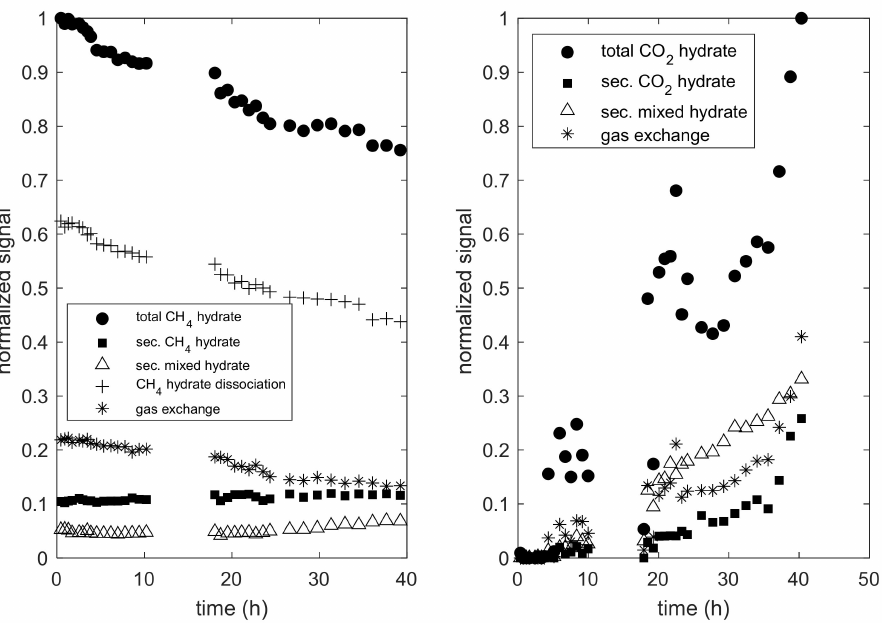
Figure 10. Evolution of the total gas-hydrate signal of experiment NoFlowI2 and evolution of the specific processes. Left: CH 4 hydrate; right: CO 2